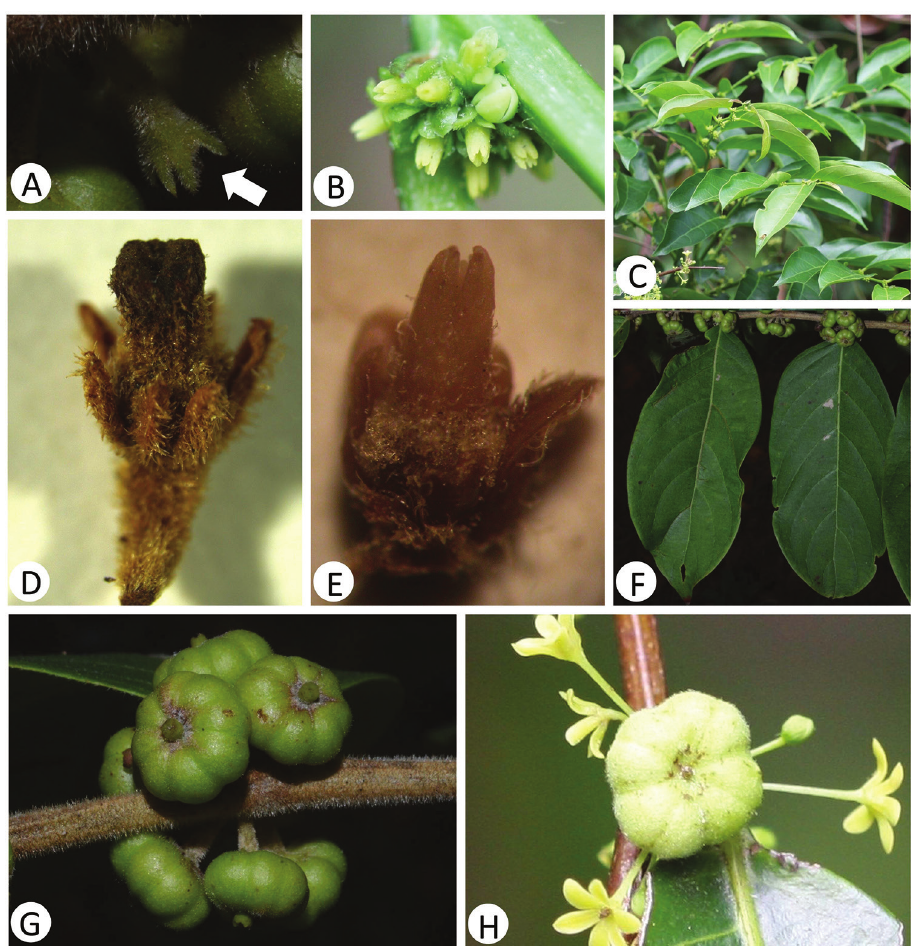
Figure 2. Morphological comparisons between Glochidion ellipticum Wight ( B, C, E, H ) and G. shanense Gang Yao & Shixiao Luo ( A, D, F, G ). A, B, D, E Female flower C, F Branchlets G, H